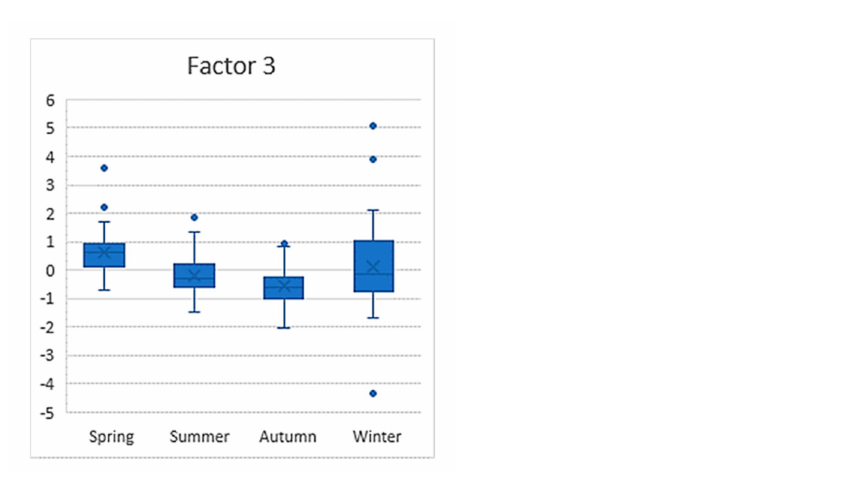
Figure 8. Boxplot for the values of the extracted factors during various seasons.